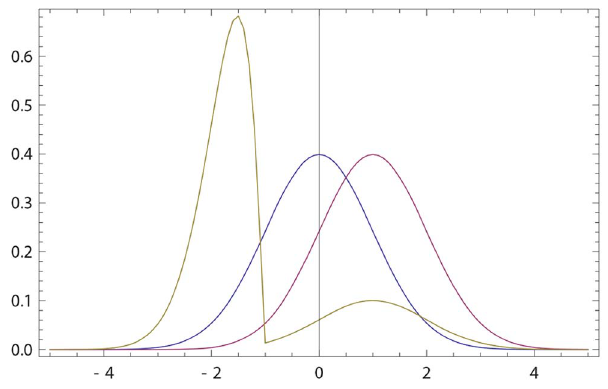
Figure 9. Repeated persuasion in the boomerang regime. Blue (resp. purple) curve: the initial opinion of agent P (resp. Q ) described by probability density p ( x ) (resp. q ( x )) as given by (17) with m P ~ 0 , v P ~ v Q ~ 1 , m Q ~ 1 . Olive curve: the opinion of P after 50 iterations (52) with E ~ 2